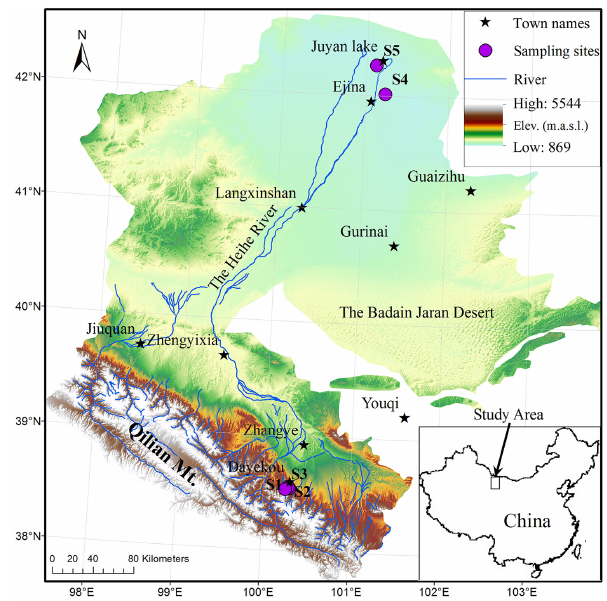
Figure 1. Locations of the sampling sites in the Heihe River basin. Note: the information about sampling locations, altitude, period of sampling and climatic conditions is listed in Table